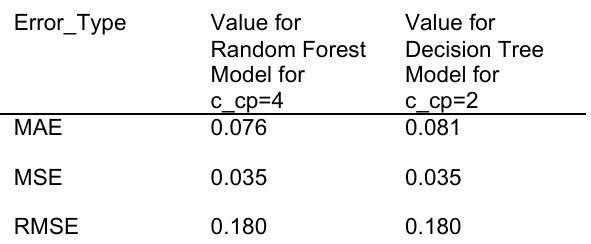
Table 9. Values of MAE, MSE, RMSE for overall data set for the Random Forest and Decision Tree Models for age greater than mean c_age